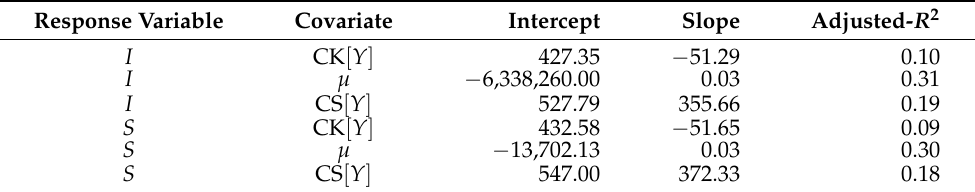
Table 8. Results of linear regression between variables with significant correlations for the simulation